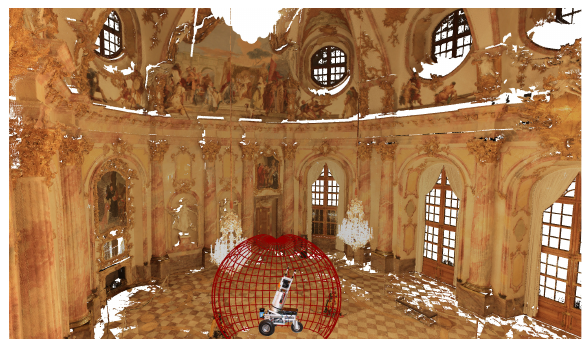
Figure 3: llustration of a 3D scan reconstruction of the imperial Hall of the W¨urzburg Residence. Data is captured by Irma3D with VZ-400 laser scanner by RIEGL Measurement GmbH. At- tached to the top of the scanner is a Canon 1000D DSLR camera. After a 3D scan has been acquired the camera is used to acquire color information for the point